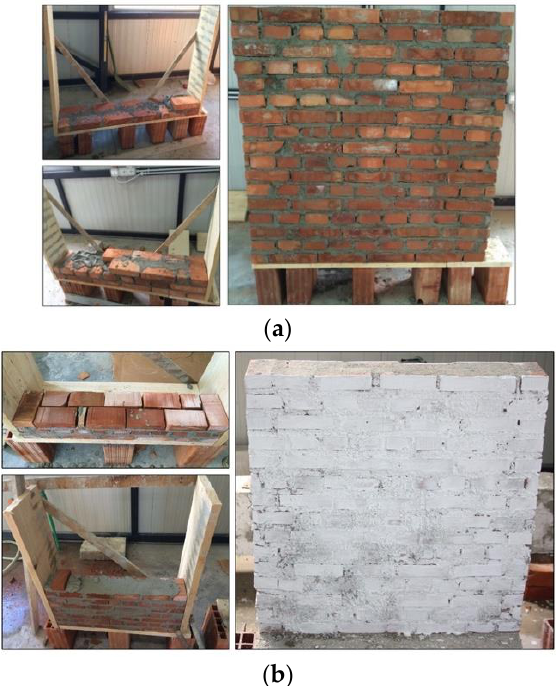
Figure 10. Construction of unreinforced panels: ( a ) full-scale (W-series) and ( b ) half-scale panel (SW-series).